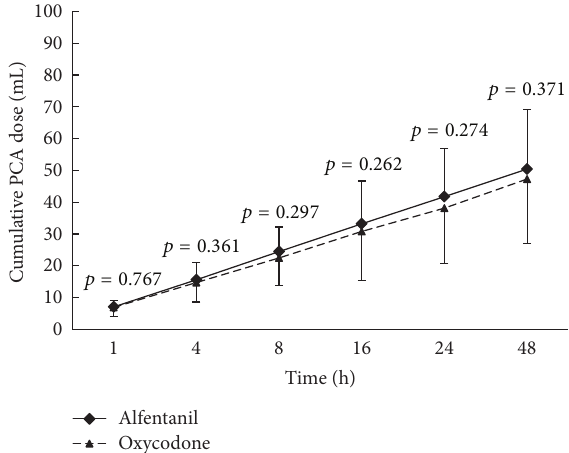
Figure 5: Cumulative patient-controlled analgesia dose measured between 1 and 48h after the operation. Means and standard deviation are shown. 𝑝 values were calculated by Mann-Whitney 𝑈 test. There were no significant differences between two groups ( 𝑝 value < 0.05). PCA: patient-controlled